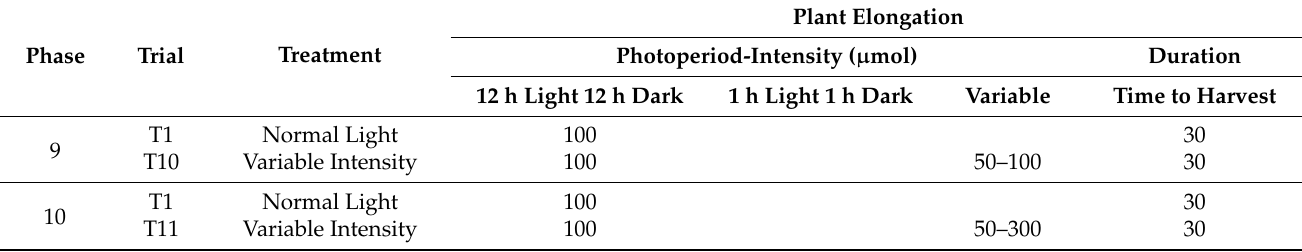
Table 5. The LED parameters for plant elongation experiment (part